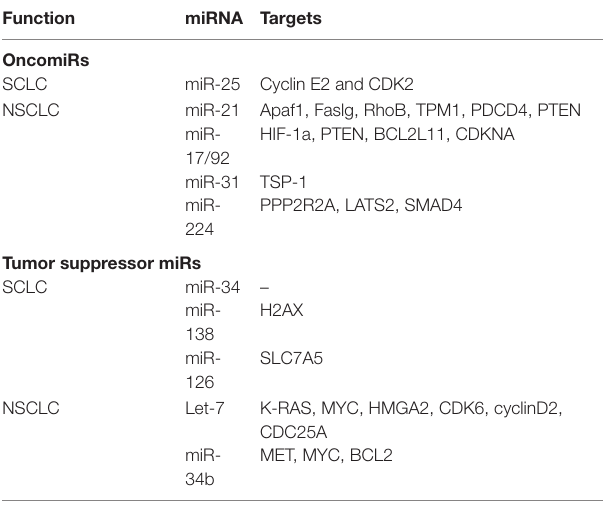
TABLe 1 | microRnAs involved in lung